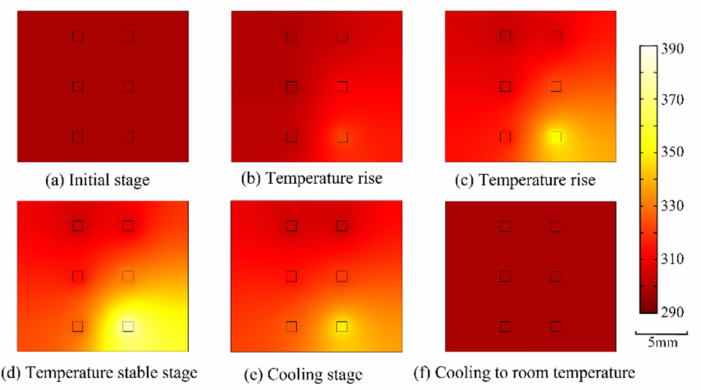
Figure 8. The temperature distribution of whole substrate in different stages ( a – f